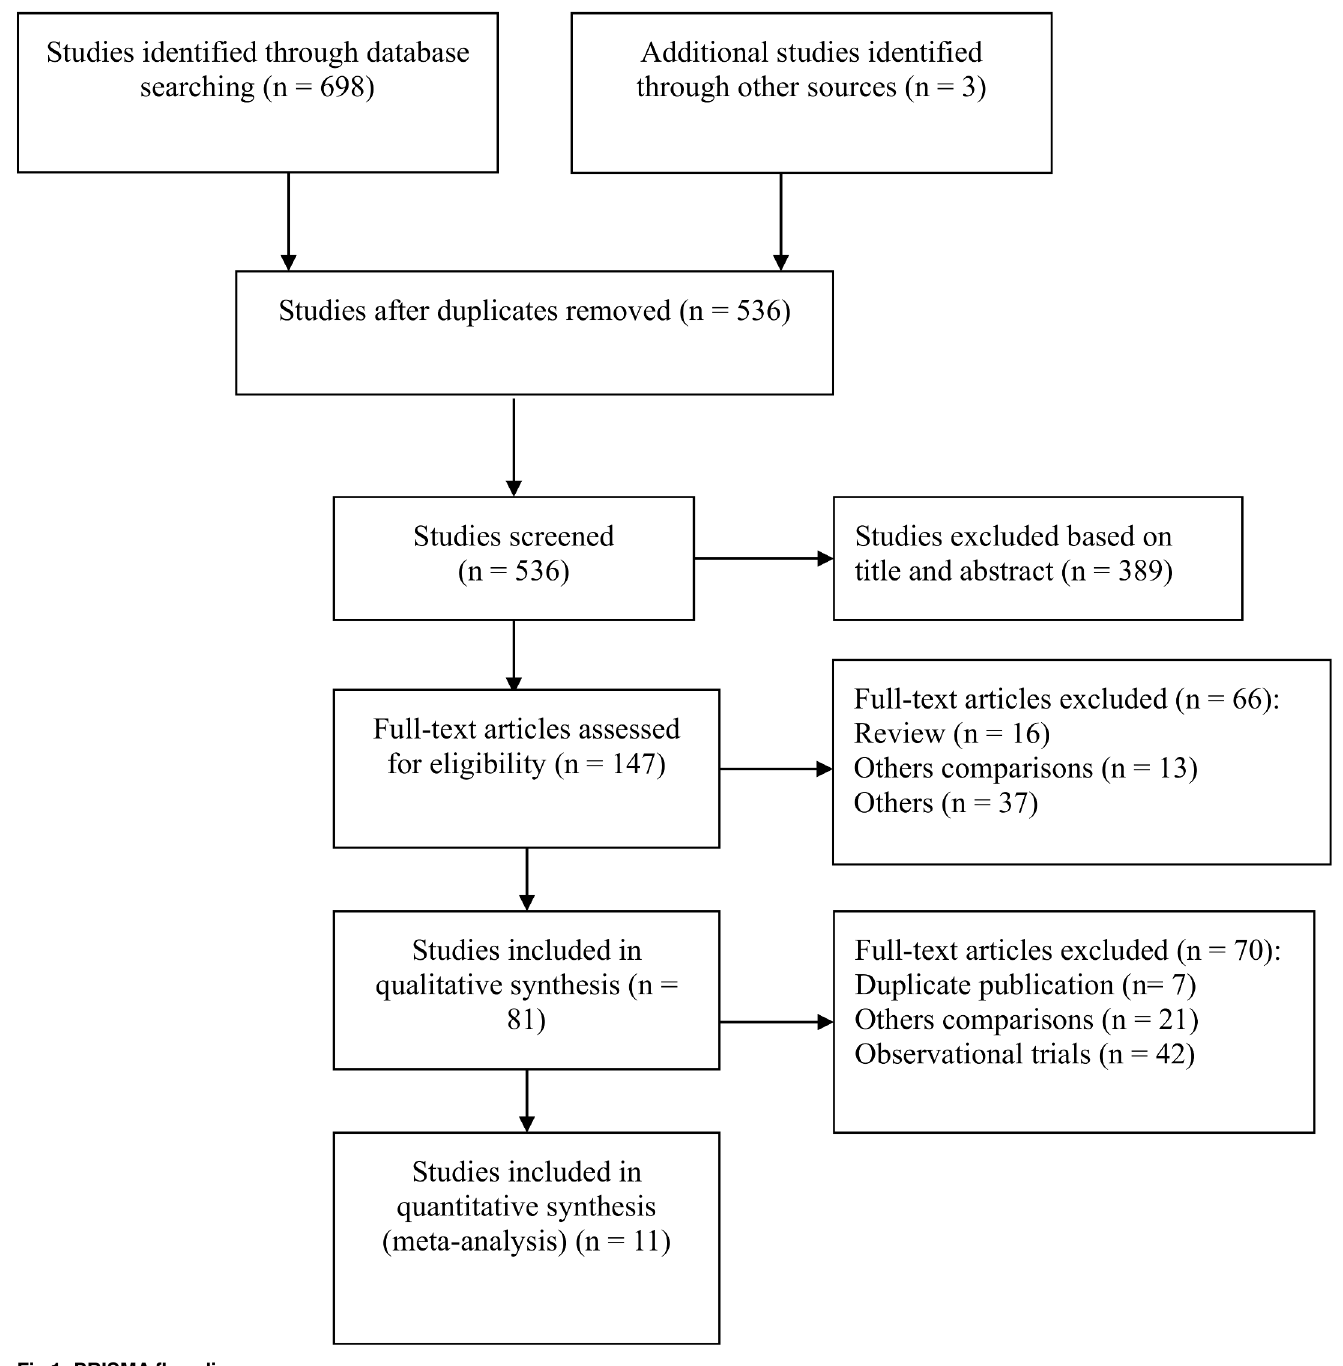
Fig 1. PRISMA flow